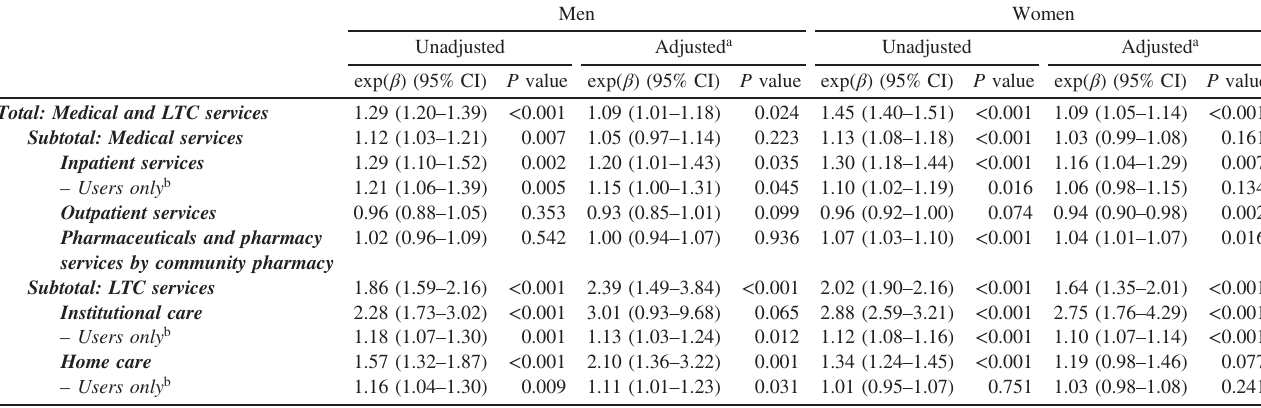
Table 5. E ff ect of low income on medical and long-term care expenditures by gender